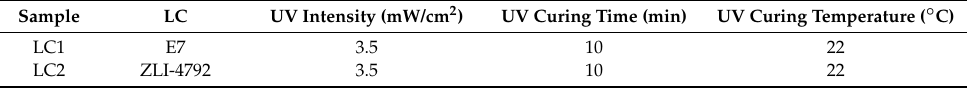
Table 2. For study on the types of liquid crystals, 1.5% RM257 was added to 2 different LC (either E7